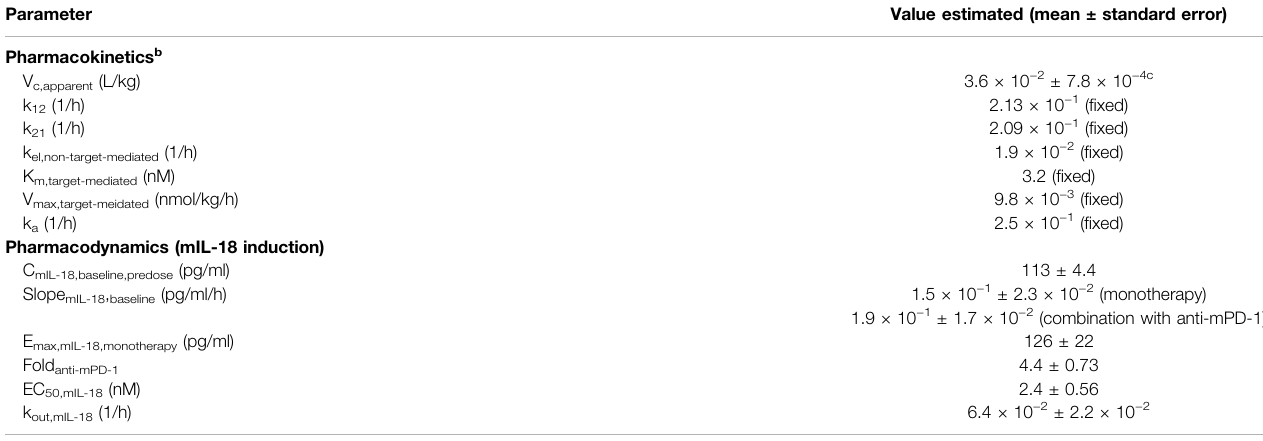
TABLE 1 | Pharmacokinetic and pharmacodynamic parameters estimated for mFc-mIL-10 after intraperitoneal administration to mice bearing CT26 syngeneic tumors at doses of 0.1 and 0.3 mg/kg either as a single agent or in combination with mouse anti-mouse PD-1 monoclonal antibody a .